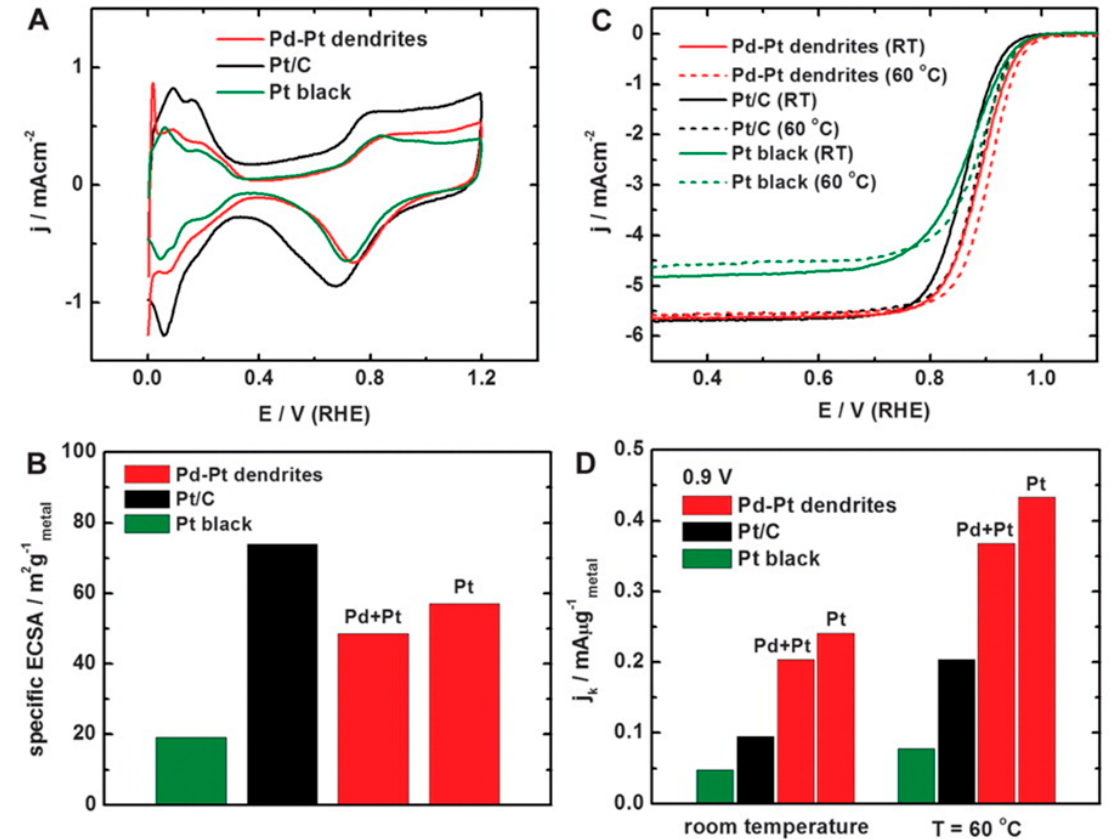
Figure 9. Comparison of the catalytic properties of the Pd-Pt nanodendrites, Pt/C catalyst (E-Tek), and Pt black (Aldrich). ( A ) The CV curves recorded at room temperature in an Ar-purged 0.1 M HClO 4 solution with a sweep rate of 50 mV s − 1 ; ( B ) specific ECSAs (electrochemical active surface area) for the Pd-Pt nanodendrites, Pt/C catalyst, and Pt black; ( C ) ORR polarization curves for the Pd-Pt nanodendrites, Pt/C catalyst and Pt black recorded at room temperature and 60 °C in an O 2 -saturated 0.1 M HClO 4 solution with a sweep rate of 10 mV s − 1 and a rotation rate of 1600 rpm and ( D ) mass activity at 0.9 V versus RHE (reversible hydrogen electrode) for these three catalysts. Reproduced with permission from reference